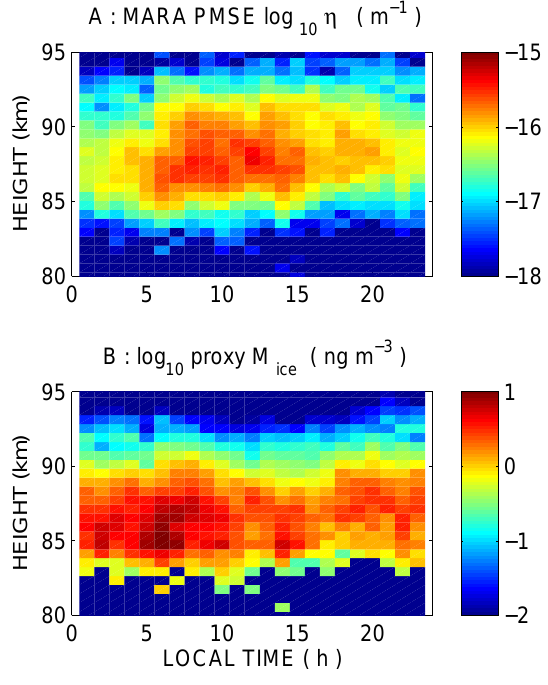
Fig. 7. Panel (A) Daily variation of measured PMSE volume re- flectivity at MARA (median values) from 6 December 2007 to 31 January 2008. Panel (B) proxy for ice mass density calculated from the PMSE reflectivity and background electron